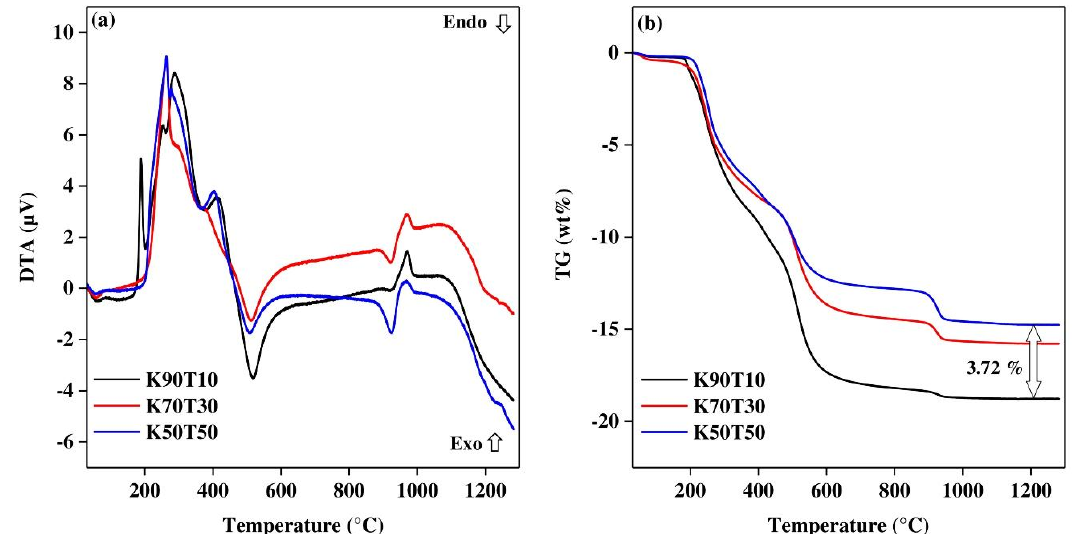
Figure 4. DTA ( a ) and TG ( b ) curves of three kaolin–talc tapes (under air up to 1200 °C), K50T50, K70T30, and K90T10.